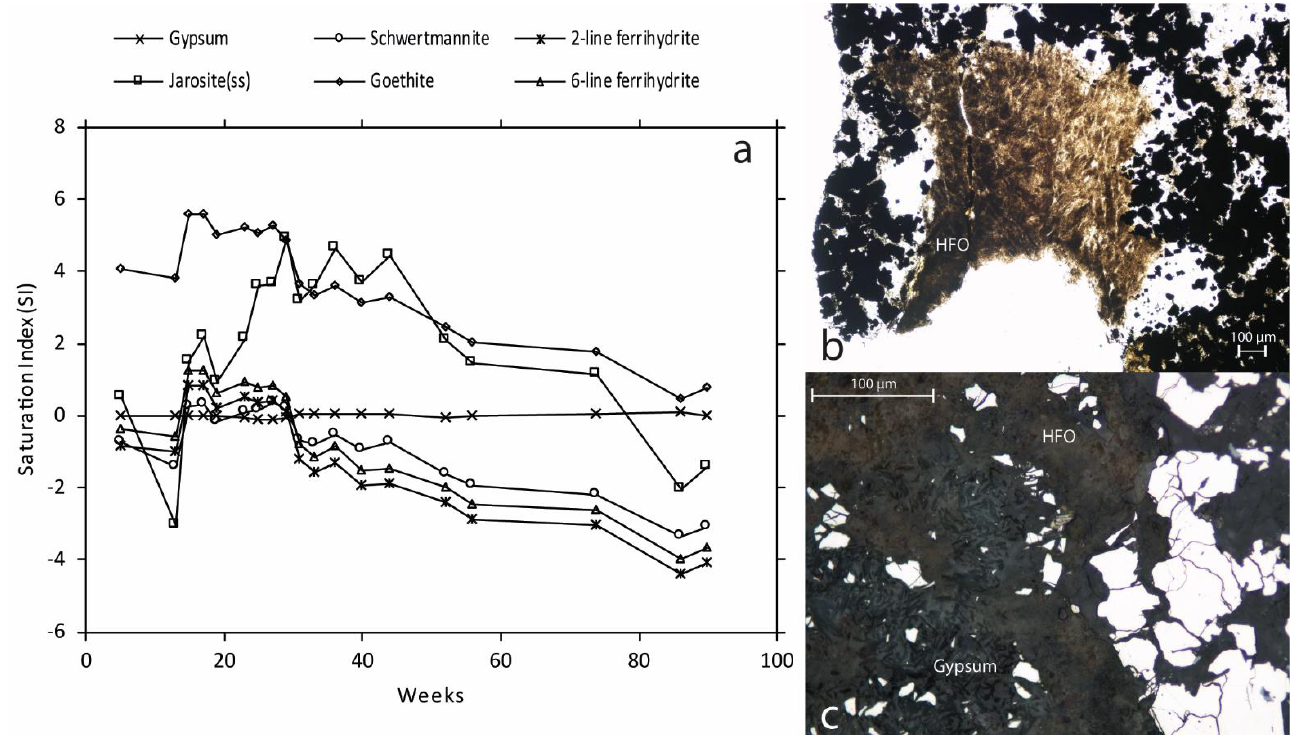
Figure 5. ( a ) Geochemical calculations of saturation index of Gypsum, Jarosite, Goethite (wateq4f.dat thermodynamic database [17]), Schwertmannite [20] originating from [21], and 6-line ferrihydrite [19] in the leaching of pyrite-rich waste rock. Dashed lines mark values close to zero (±0.5) which indicate equilibrium between the solution and mineral phase. Petrographical microscopic images after leaching the waste rock for 52 weeks. ( b ) Inferred HFO overgrowing muscovite (sericite). ( c ) Inferred Gypsum and HFO formation in bulk (between mineral grains).